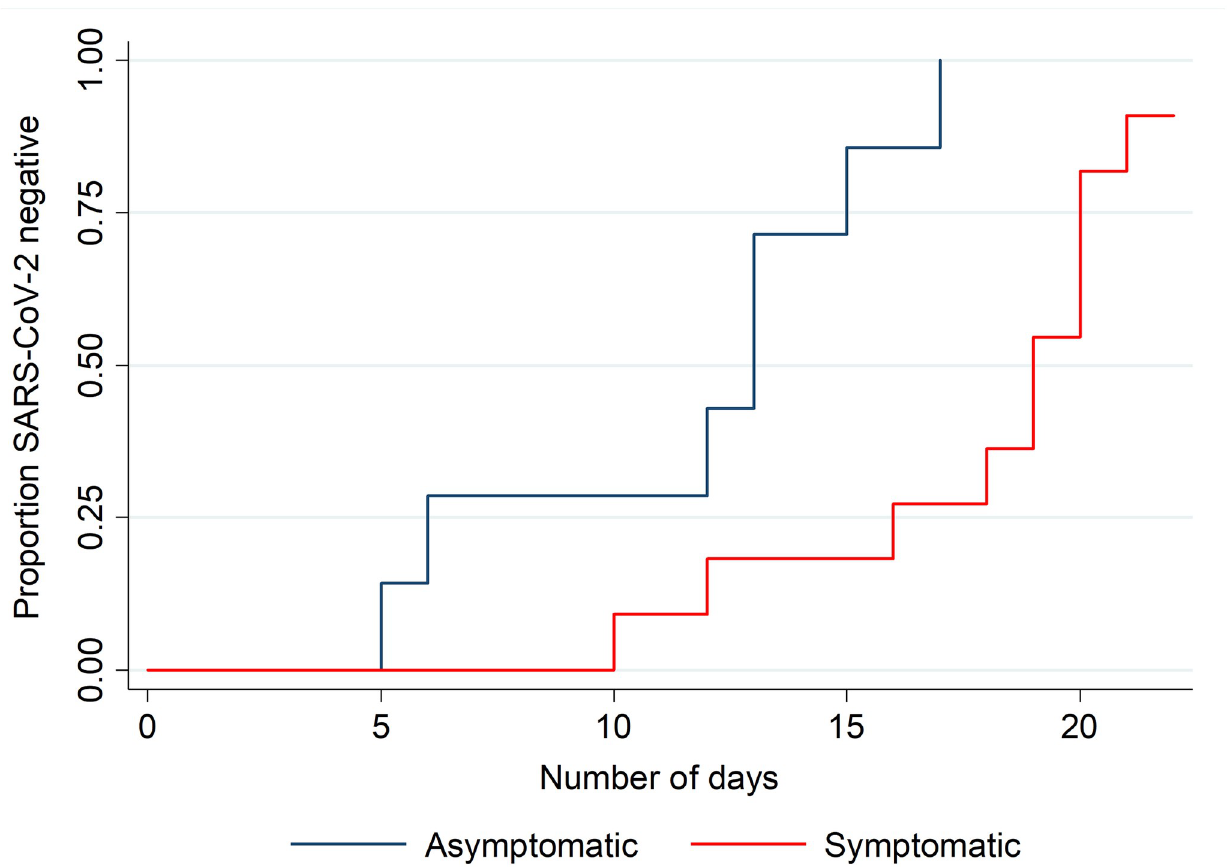
Fig 3. Cumulative proportion virologically cleared by symptom status and time of follow-up (n = 18), March 2020.